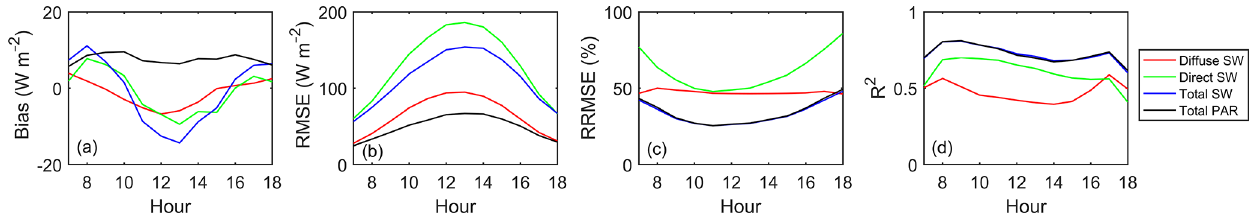
Figure 5. Evaluation of EPIC-based hourly SW–PAR estimates at different local hours from 07:00 to 18:00 local solar time.